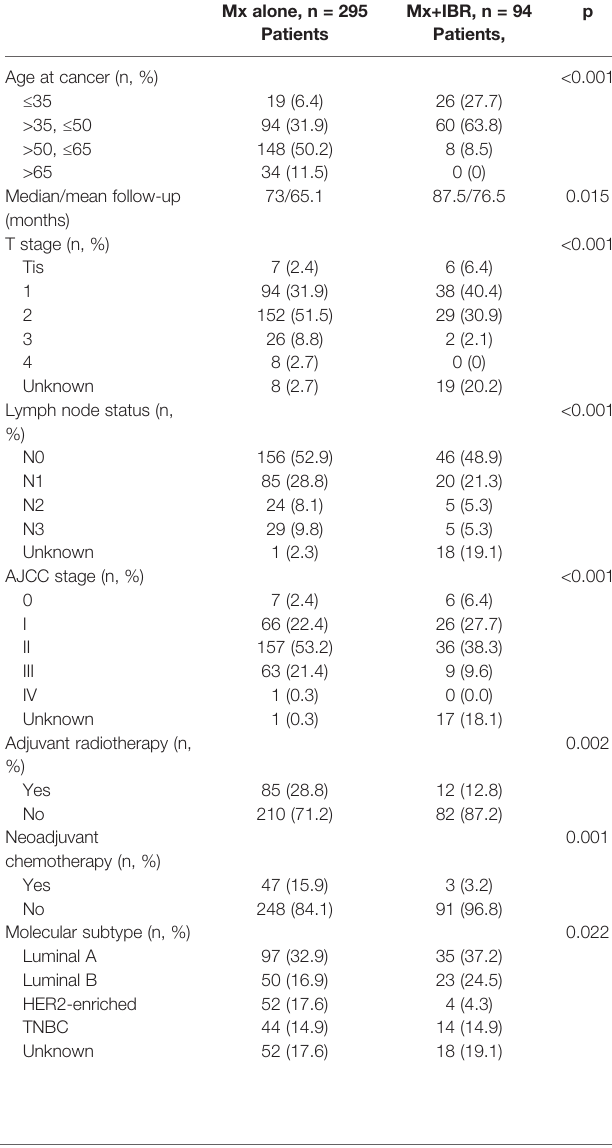
TABLE 1 | Patient demographics, clinical and pathological characteristics, and systemic treatments in mastectomy only (Mx alone) group and mastectomy and immediate breast reconstruction (Mx+IBR) group.